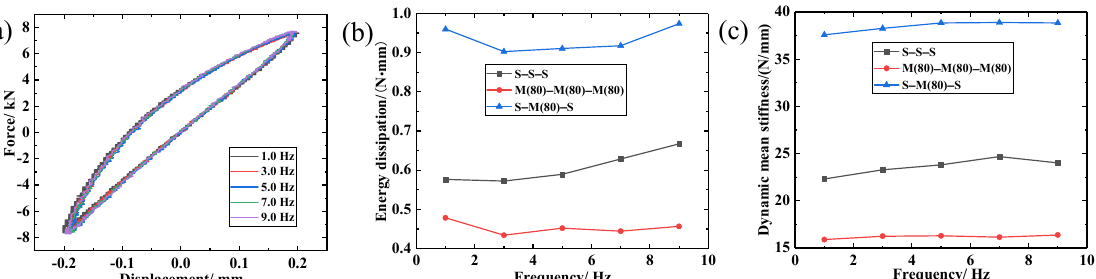
Figure 16. Dynamic performance of LCDS under different frequencies: ( a ) Hysteresis loops under different frequencies; ( b ) Variation of dynamic mean stiffness under different frequencies; ( c ) Variation of energy dissipation under different frequencies.